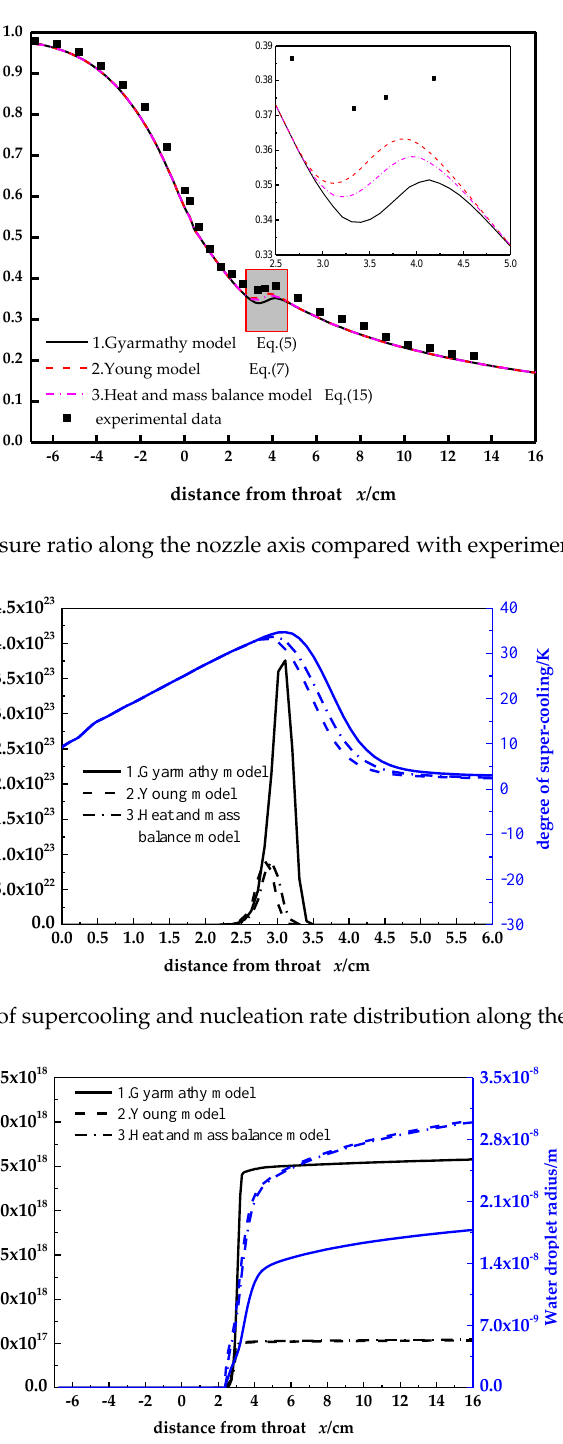
Figure 6. Geometric data of the de Laval nozzle.